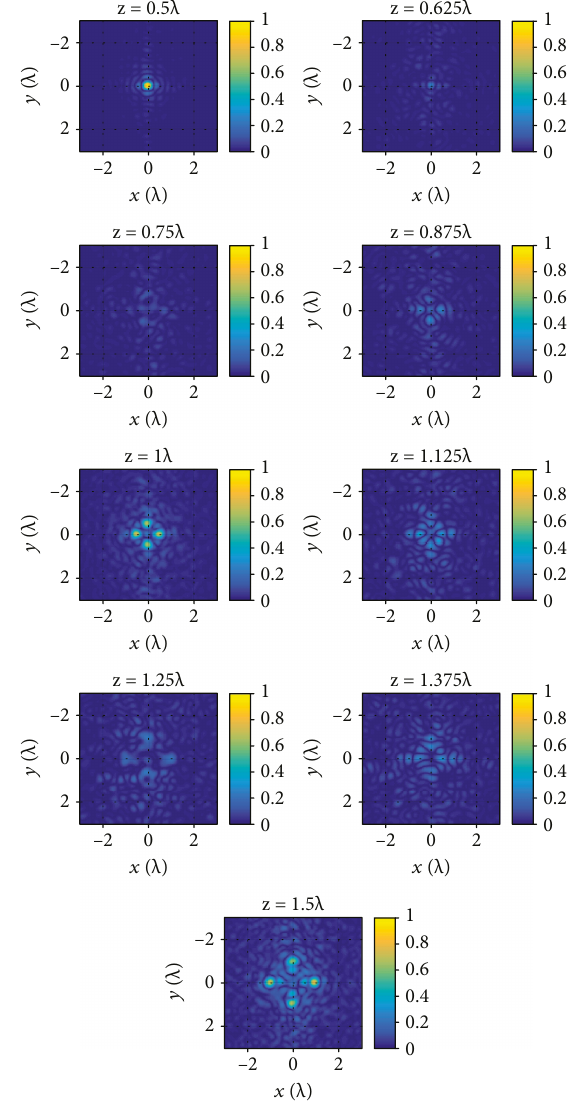
Figure 18: 3D imaging results for the example 1 shown in Figure 16(a). The number of imaged planes has been increased compared to the results in Figure 17(a). The distance between the planes is λ /8 (the resolution determined by the 2D study). These results are with SNR =30